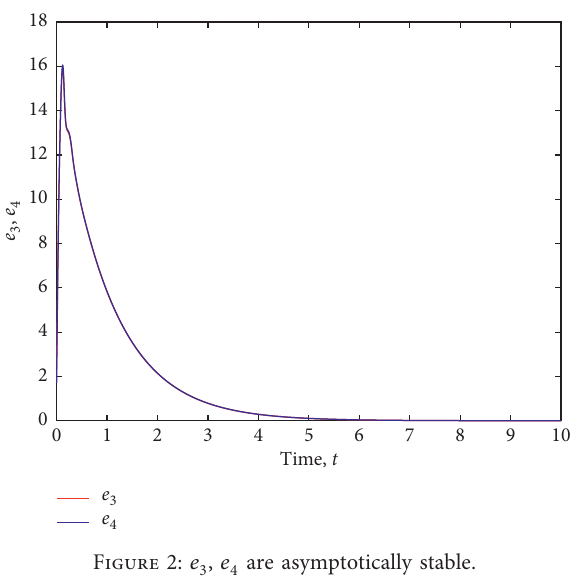
, e are asymptotically stable. 1 2